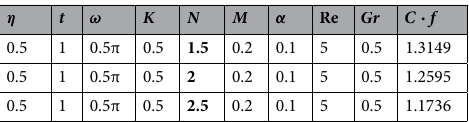
Table 1. Influence of radiation parameter N on skin friction.